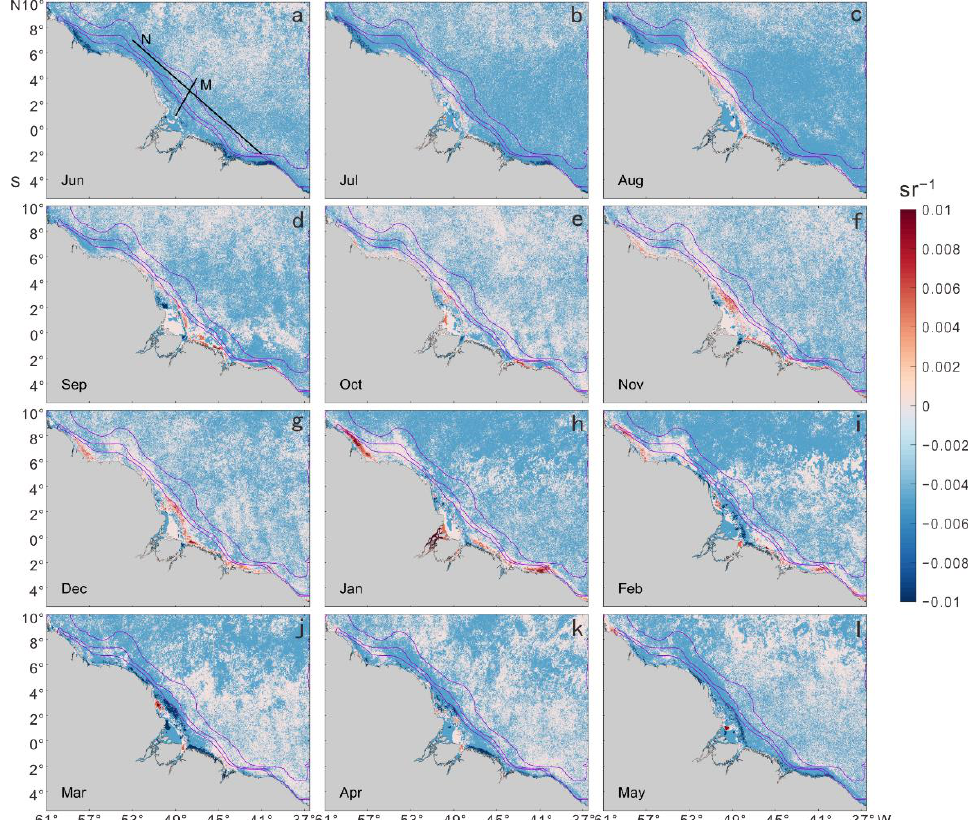
Figure 3. The deviation between the monthly average and annual average remote-sensing reflec- tance (R rs ) at the 555 nm band over 10 years off the Amazon estuary (2008 – 2017). The purple contour lines from the estuary to the sea are the 50 m, 200 m, and 2000 m isobaths. ( a – l ) correspond to the winter period (June – November) and summer period (December – May) in the southern hemisphere, respectively (unit: sr −1 ). Transects M and N are indicated in ( a ).